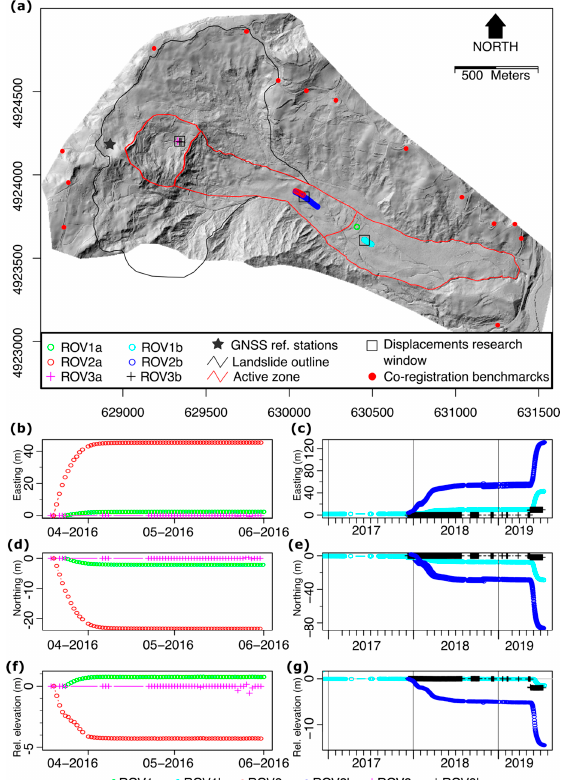
Figure 2. Global Navigation Satellite System (GNSS) records. ( a ) Planimetric view; Plots ( b , d , f ) present relative coordinate variations recorded in the period from 24 March 2016 to 15 July 2016. Plots ( c , e , g ) present relative coordinate variations recorded in the period from 28 November 2016 to 15 July 2019. GNSS time-series are presented in Mulas et al. [39]. Grid coordinates: WGS84/UTM32N (EPSG: 32632).